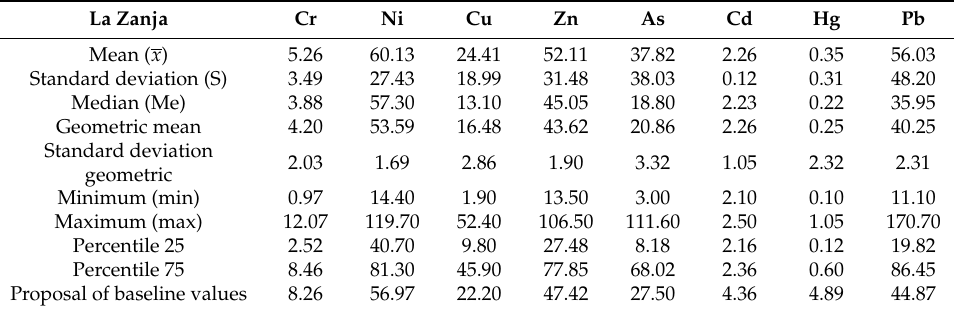
Table 3. Statistical analysis of heavy metals in all horizons (surface and mother rock) of the soils of La Zanja and the geochemical